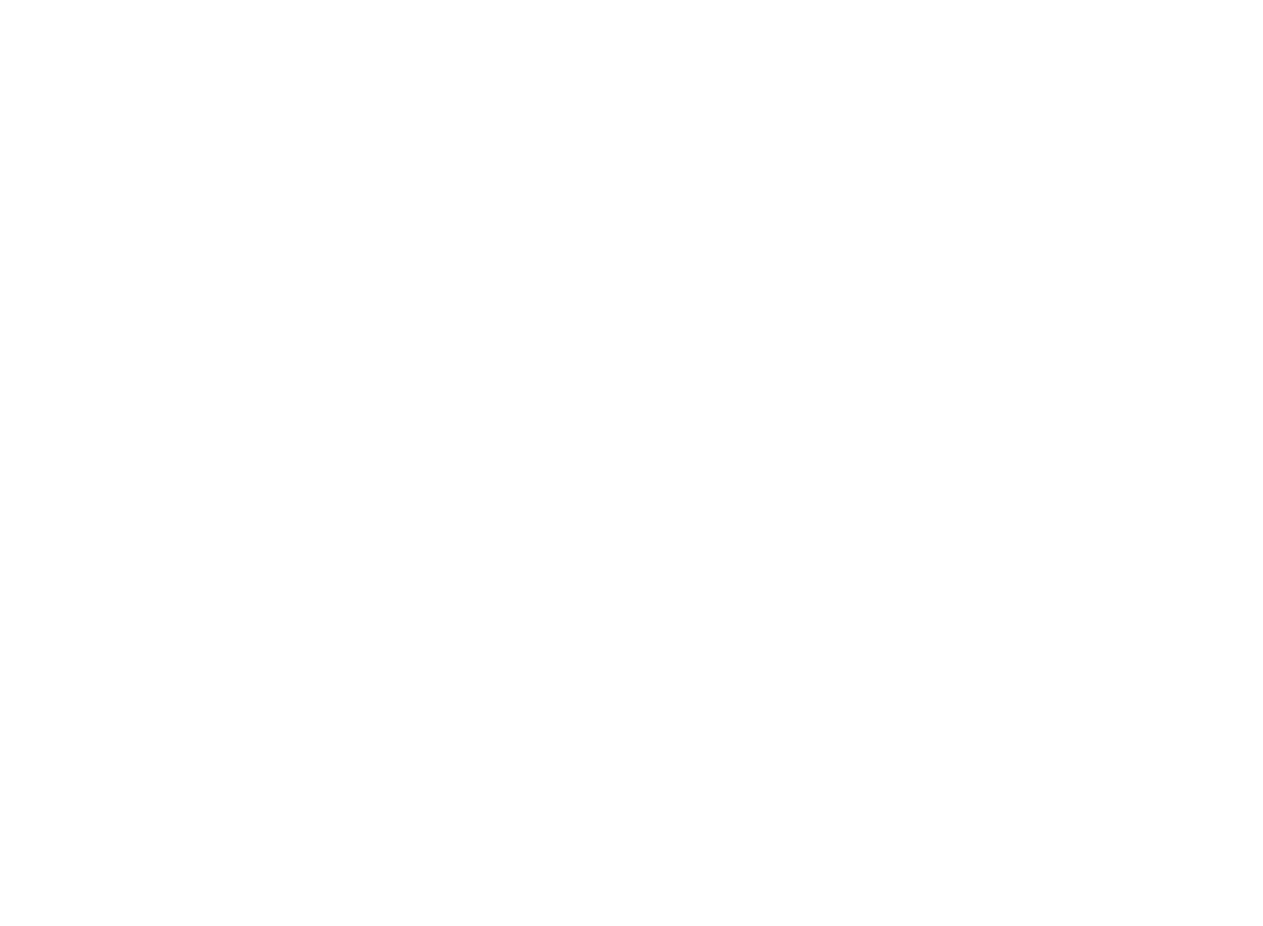
Frontiers in Psychology |